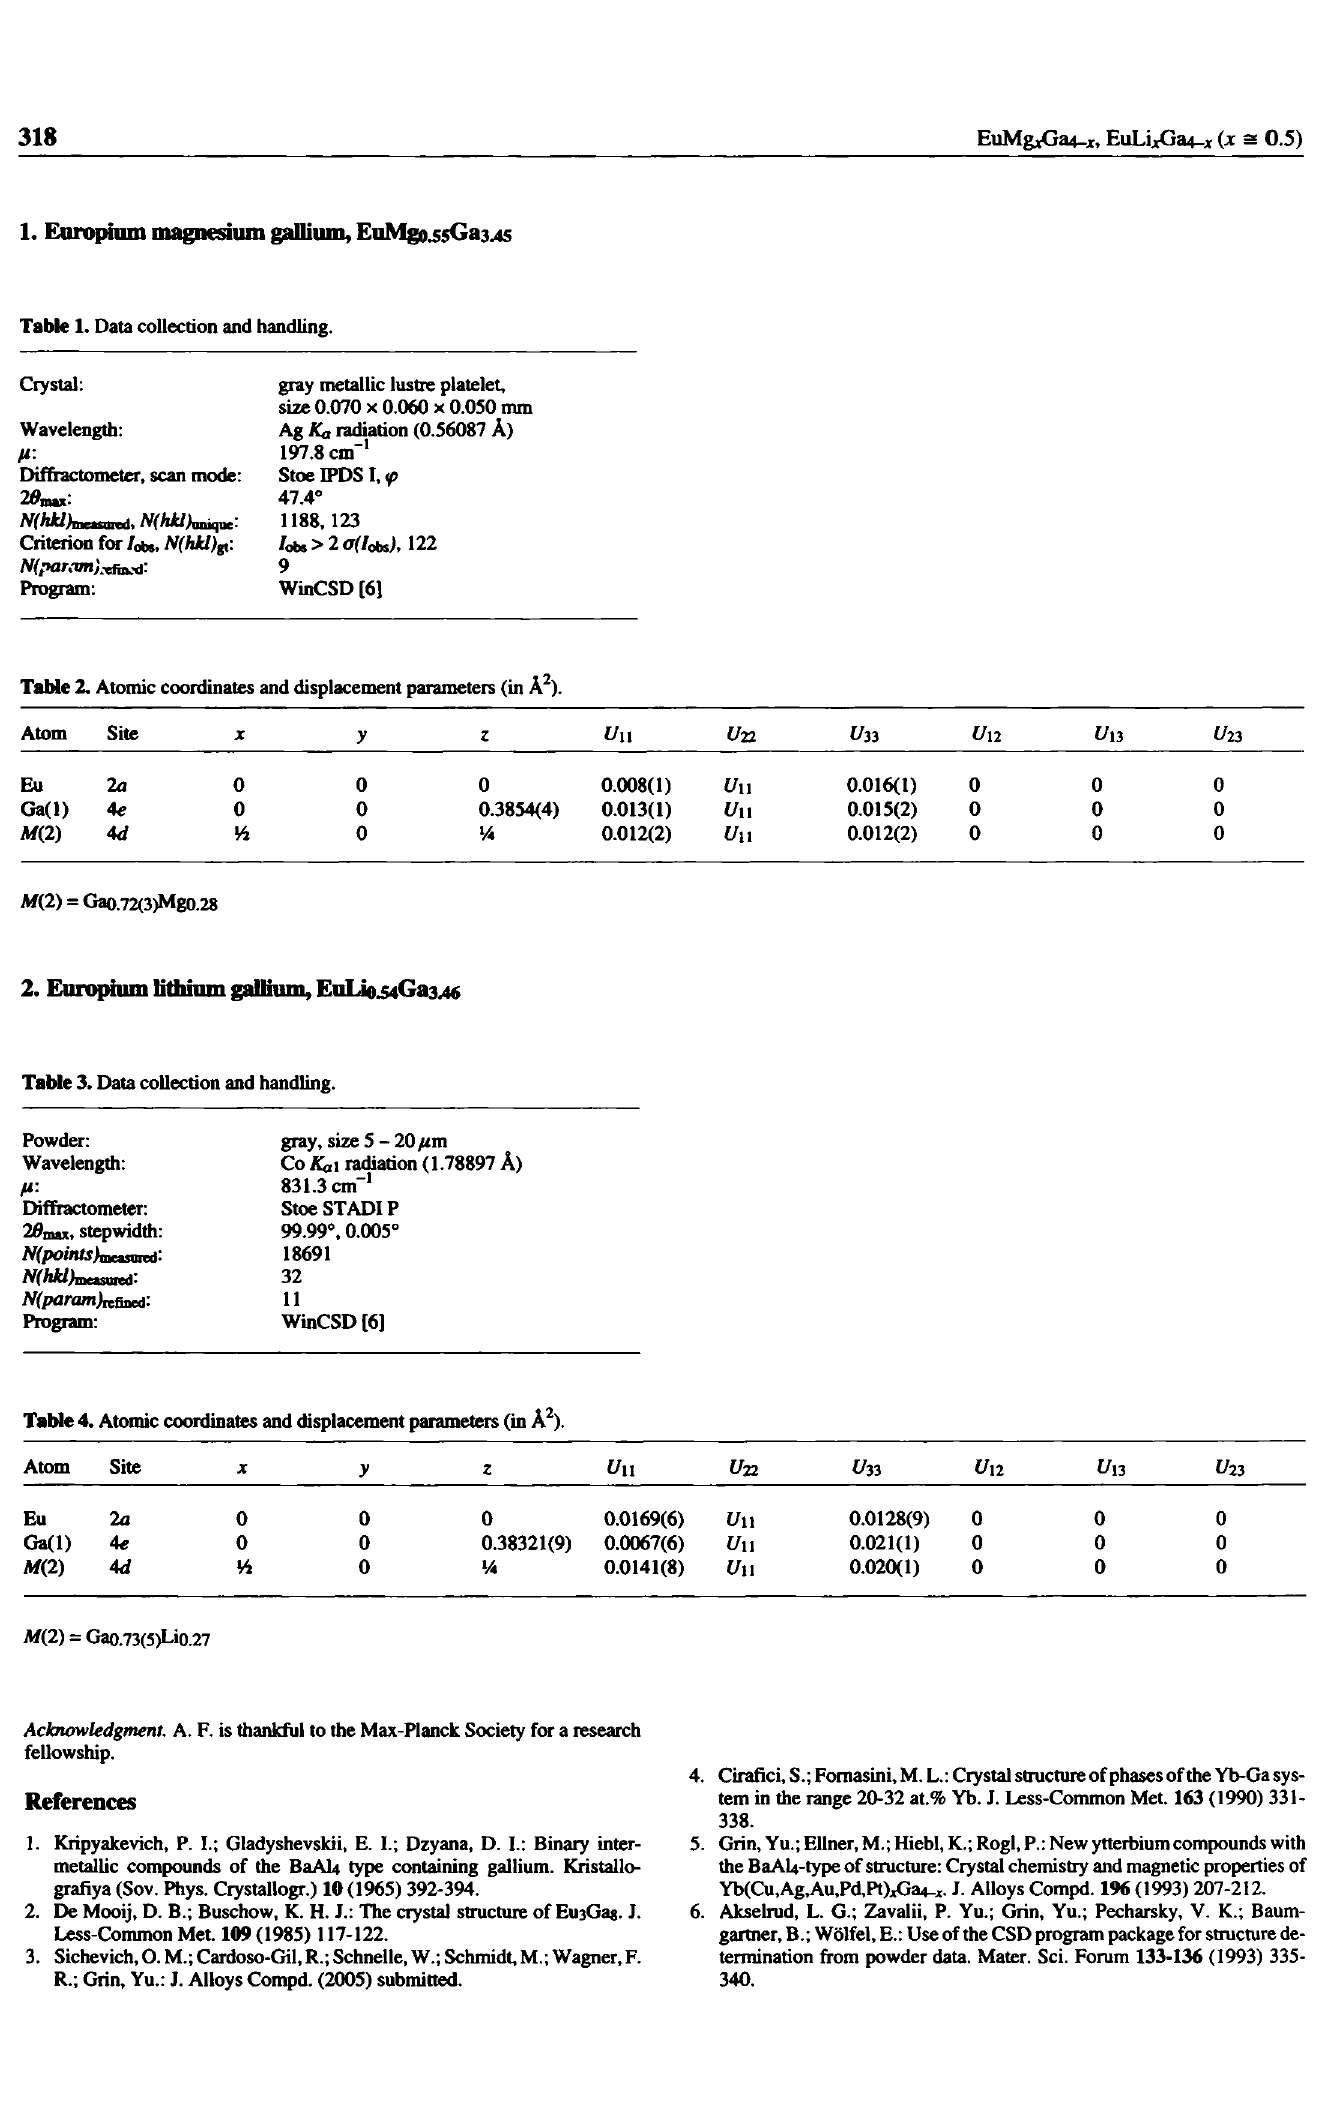
Table 1. Data collection and handling.